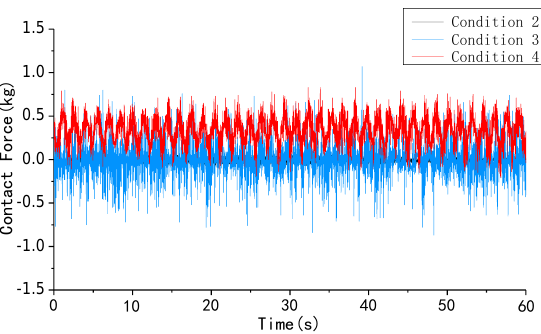
Table 6. Wet-towing conditions (speed as main variable).